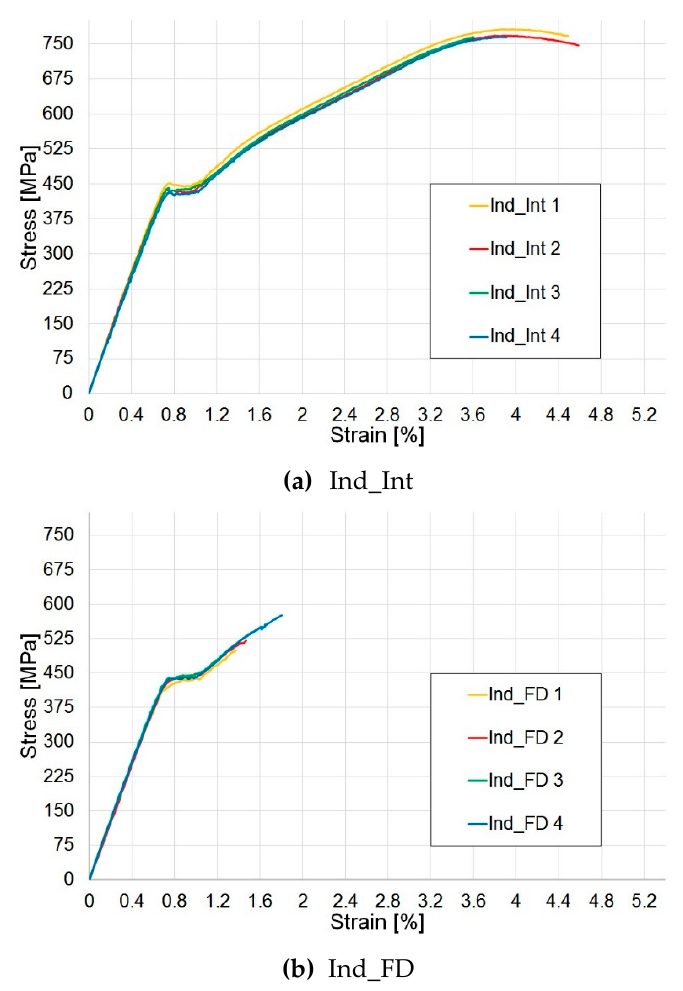
Figure 10. Tensile tests: post-indentation results. ( a ) Indented Interrupted (Ind_Int) and ( b ) Indented Fully Damaged (Ind_FD) specimens.